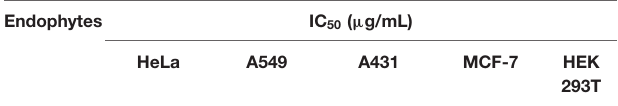
TABLE 4 | IC 50 value of Aspergillus unguis (AG1.2) on multiple human cancer cell lines by MTT and resazurin